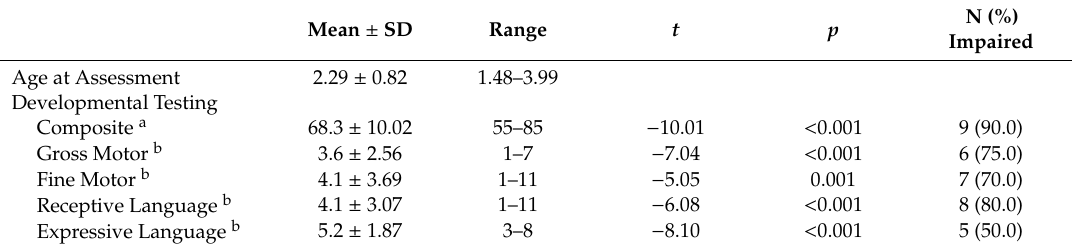
Table 2. Functioning of young children on measures of developmental functioning (n = 10).